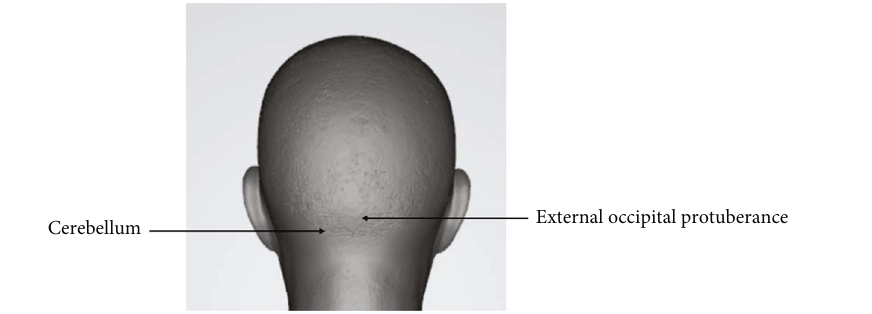
Figure 2: Schematic diagram of the